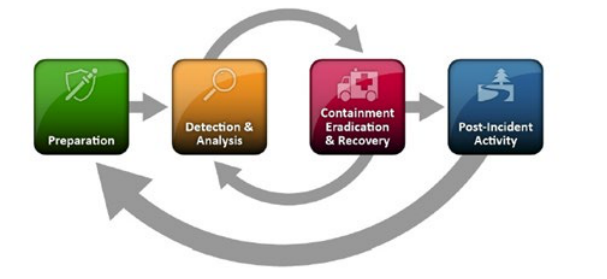
Figure 1. Incident Response Life